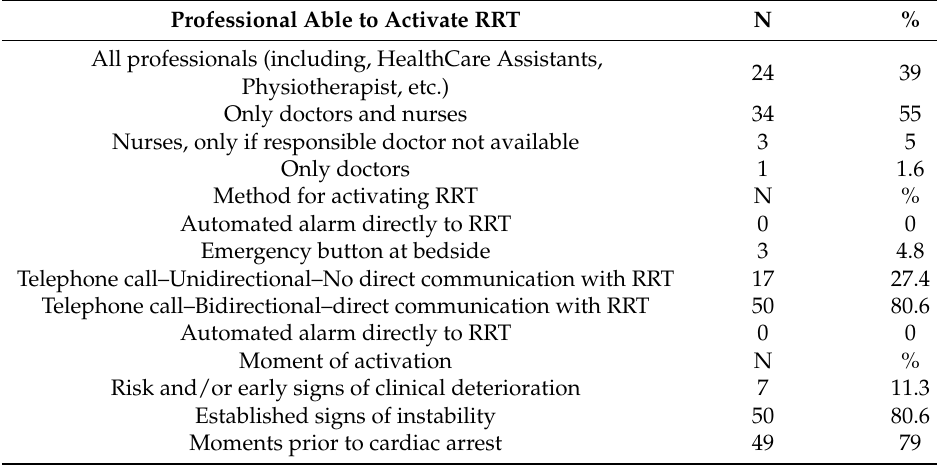
Table 2. Afferent limb: activating the